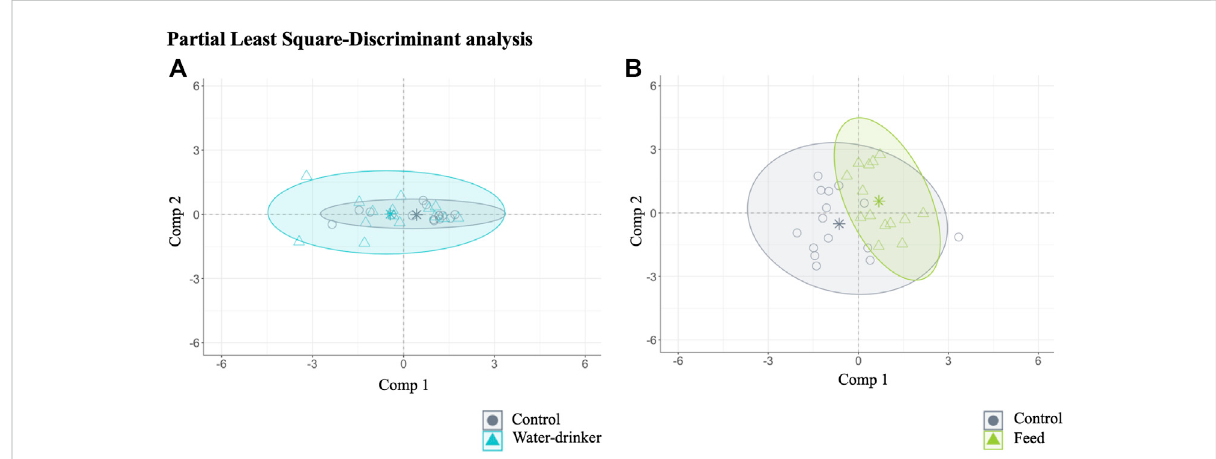
FIGURE 2 Caecal microbiota features characterised for Salmonella -free broilers treated with a Salmonella phage. Caecal microbiota composition dissimilarity through the representation of the fi rst (Comp 1) and second components (Comp 2) of the identi fi ed 11 relevant variables (genera) in the fi nal partial least square-discriminant analysis (PLS-DA) models (A) from the water vs. control groups, and (B) from the feed vs. control groups. The water group (blue) received a 10 8 PFU/ml phage concentration via drinking water. The feed group (green) received a 10 8 PFU/g phage concentration via feed (encapsulated). The control (grey) group did not receive a